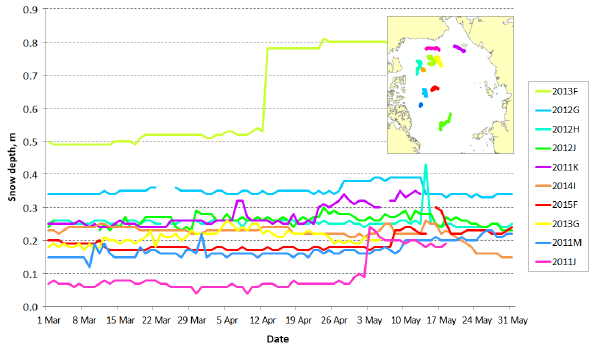
Figure 12. IMB observations of snow depth in the MAM months, 2012–2016, provided by CRREL. The number before a letter in the buoy’s name indicates the year when the buoy was deployed. Tracks of the buoys in the MAM months are shown on the map.